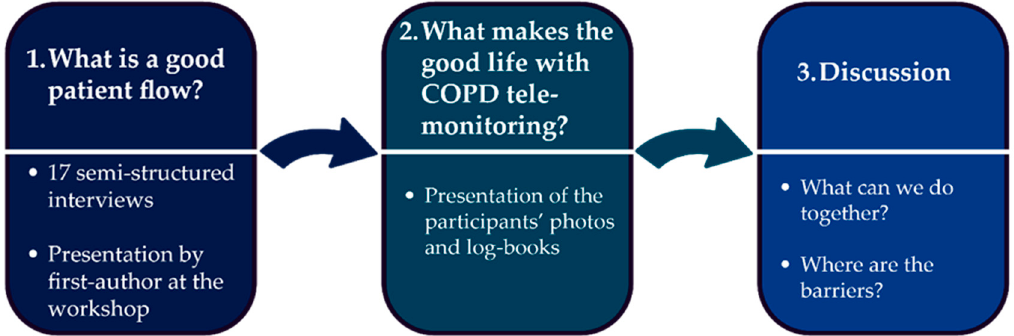
Scheme 1. Flowchart illustrating sequences/tasks at the three-hour